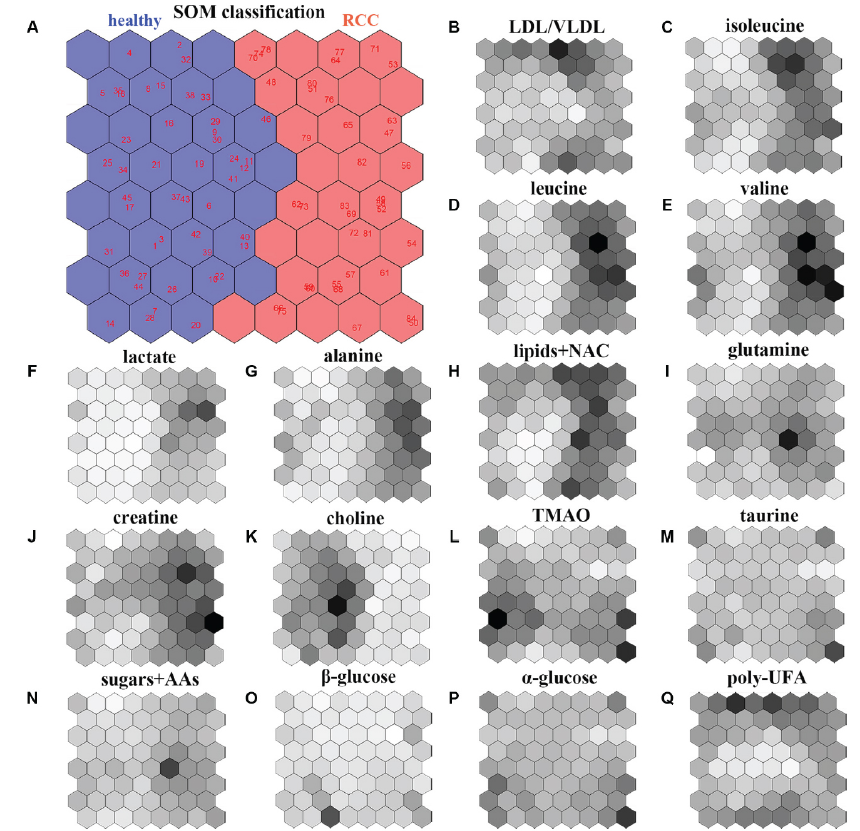
Figure 4. An example of SOM model for studying renal cell carcinoma (RCC). ( A ) SOM classification and discrimination between healthy subjects (left region) and RCC patients (right region) by consider- ing 16 metabolites extracted by means of NMR spectroscopy on serum samples. ( B – Q ) Weight maps of the considered 16 metabolites. Darker colors correspond to higher SOM weights. Figure reprinted from Ref. [52] under the terms of the CC-BY